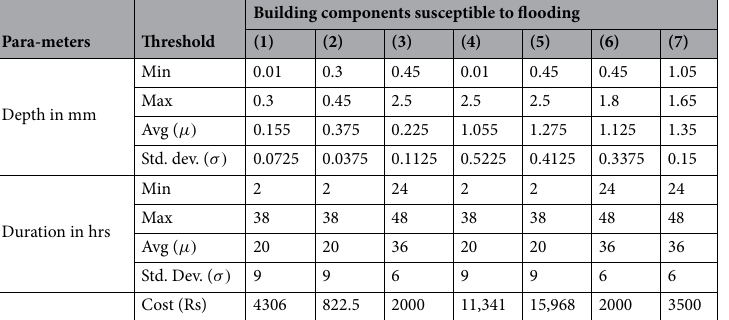
Table 1. Damage table of mud housing in Sagar. 1- Brick and mud plinth, 2- mud floor, 3- bamboo column, 4 – mud plaster, 5- mud wall, 6 -wooden door, 7- wooden window.